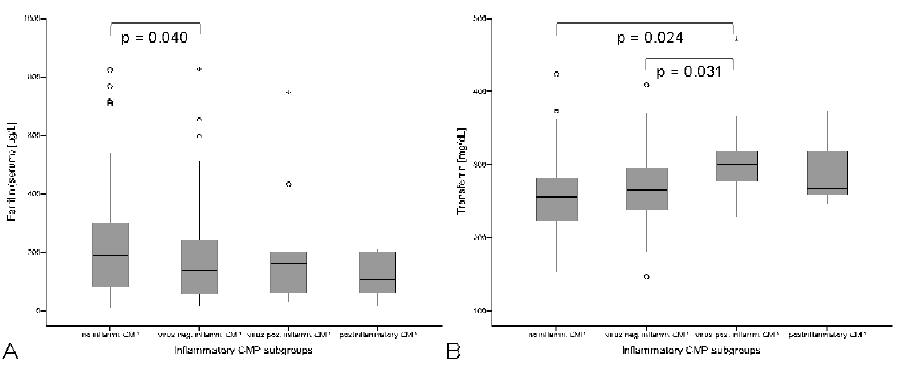
Figure 2: Boxplots of ferritin and transferrin levels in the different inflammatory CMP subgroups: Ferritin levels were significantly lower (134 µg/L [58 – 221] vs. 188 µg/L [80 – 297], p = 0.026 , A ) and transferrin levels significantly higher (272 mg/dL [245 – 303] vs. 257 mg/dL [223 – 281], p = 0.024 , B ) in patients with inflammatory CMP compared to those with no inflammatory CMP. Other iron metabolism parameters did not differ.